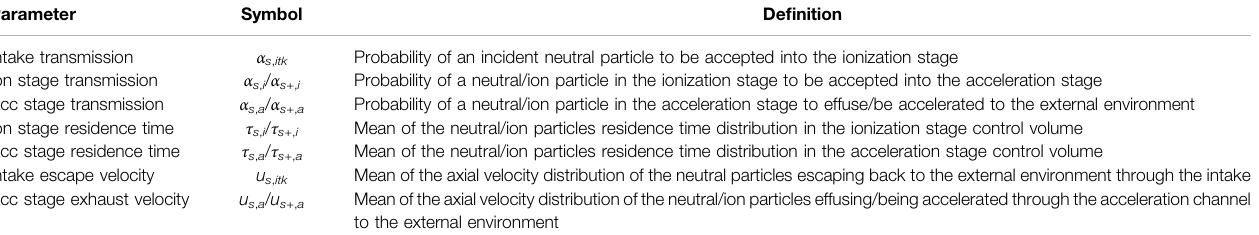
TABLE 1 | Neutral and ion fl ow parameters computed by Monte Carlo methods. Parameter